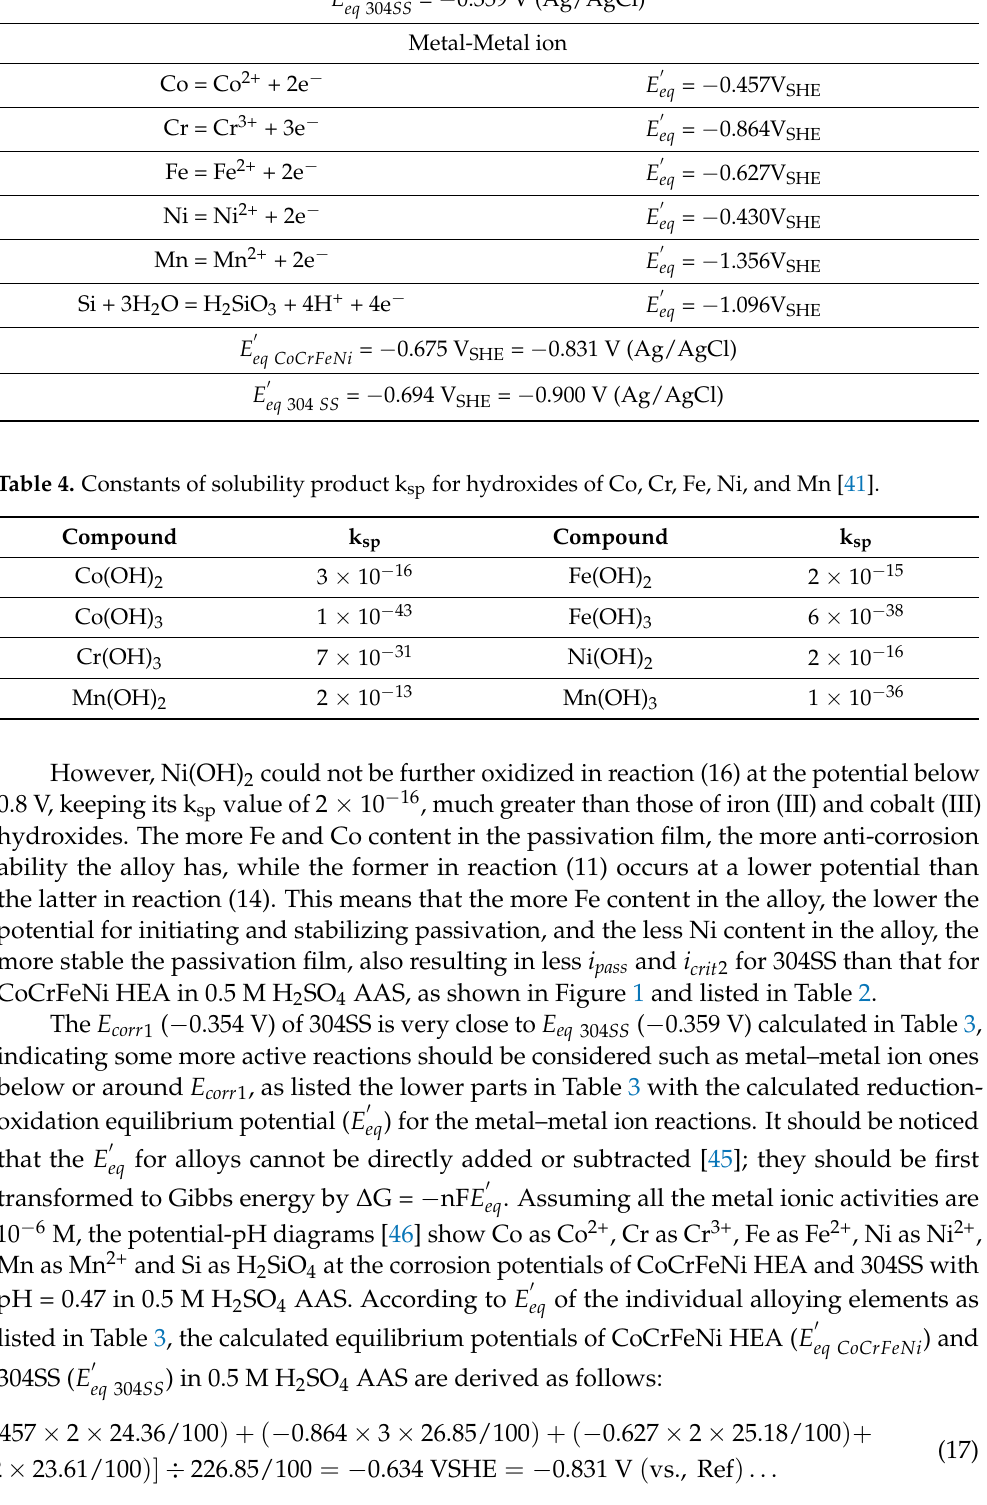
listed in Table 3, the calculated equilibrium potentials of CoCrFeNi HEA ( E (cid:48) 304SS ( E ) in 0.5 M H 2 SO 4 AAS are derived as eq 304 SS